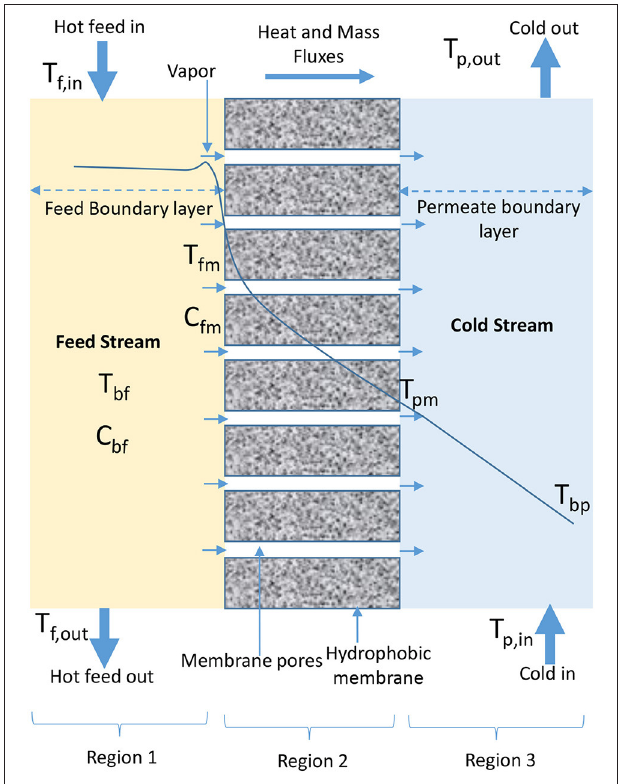
FIGURE 1 | Heat and mass transfer in DCMD configuration (adapted from Khayet and Matsuura, 2011f).